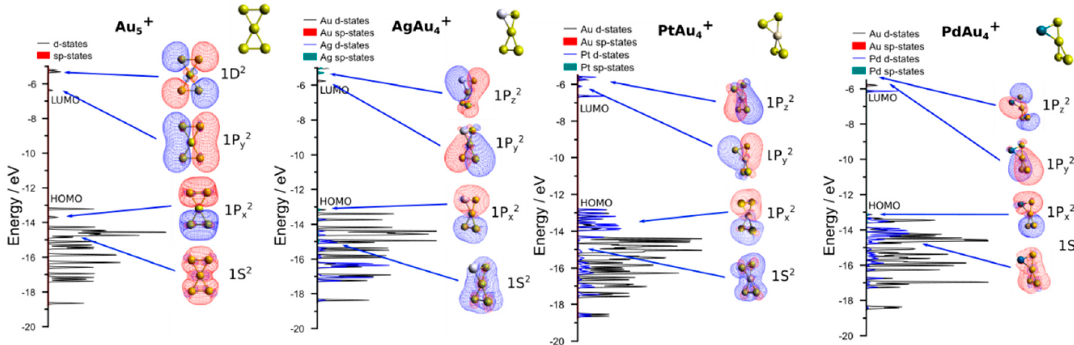
Figure 6. Total density of states of the clusters composed of N = 5 atoms. Projections into atomic states are presented in black for Au(d), in red for Au(s p ), in blue for M (d), and in green for M (s p ). The molecular orbitals of delocalized character extending over the entire cluster volume are plotted and labeled based on their nodal character (1S and 1P x,y,z ). The HOMO-LUMO gap is labeled. In the case that the cluster is open-shell, both α and β orbitals are plotted.